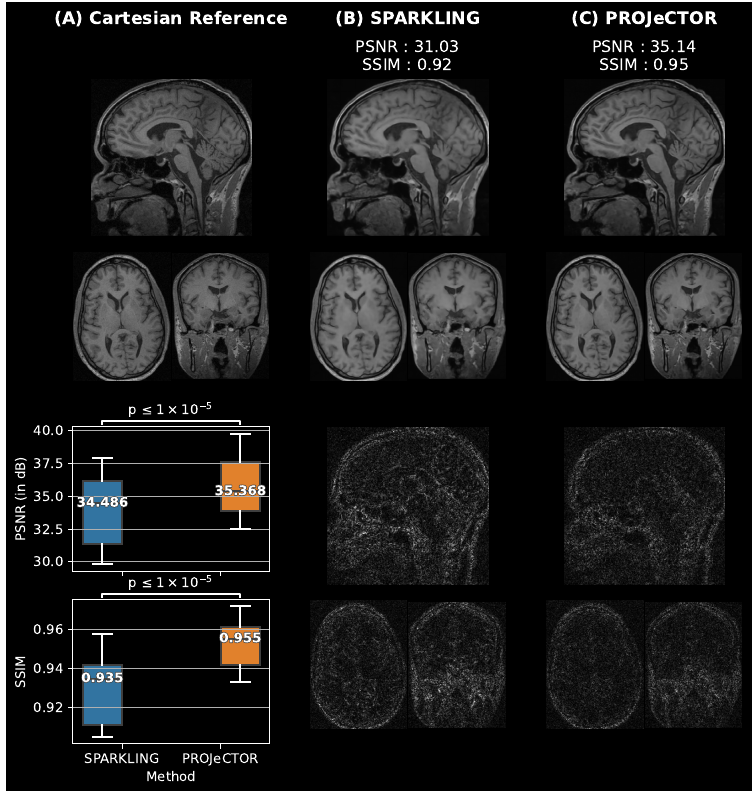
Figure 8. Qualitative and quantitative comparisons of reconstructed images from 3D ( B ) SPARKLING and ( C ) PROJeCTOR trajectories at AF = 20 as compared to ( A ) Cartesian reference. The reconstructed images are shown in the top row, while the residuals are shown in the bottom. Further, box plots of the SSIM and PSNR scores on 20 test data sets are shown in the bottom-left. The significance levels are marked through a paired samples Wilcoxon